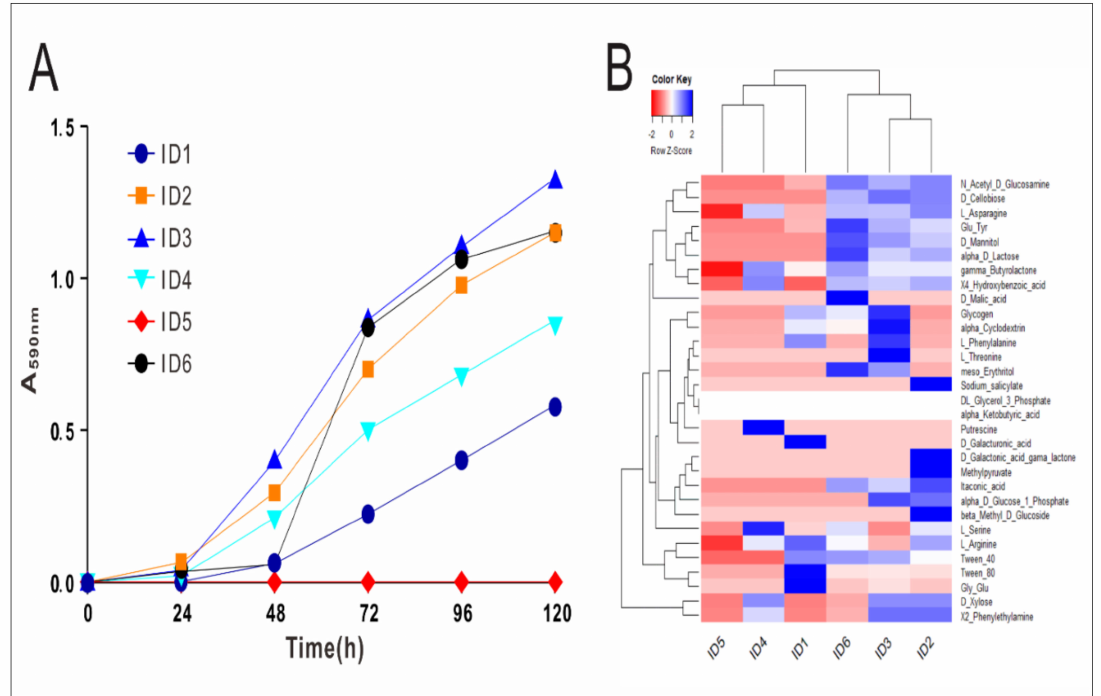
Figure 5. Community-level patterns of the different dump site soil bacterial community carbon metabolism. ( A ) Average well color development of the BIOLOG Ecoplate indicating the catabolic activity progression of the bacterial consortia in the different dumping sites over time. ( B ) Heat map showing the diverse bacterial catabolic activities against different substrates in the illegal dumping